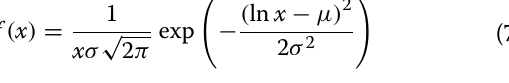
with increasing channel height.